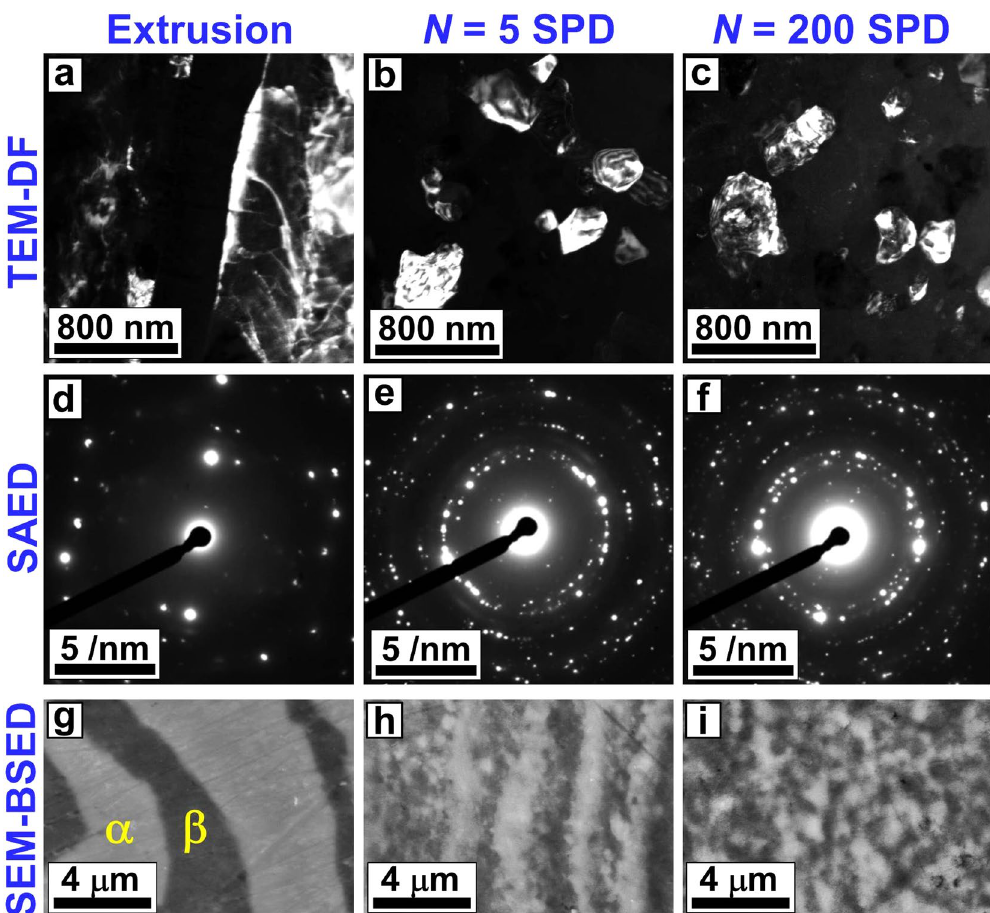
Figure 2. Ultrafine grains with average sizes of 460 nm and 240 nm are formed, and the fraction of α / β interphase boundaries increases to 0.55 μ m 2 / μ m 3 and 2.34 μ m 2 / μ m 3 in response to SPD processing for N = 5 and 200 cycles, respectively. Microstructure of Mg-Li alloy processed with extrusion and SPD for N = 5 and 200 cycles. ( a – c ) TEM-DF images showing the grain sizes. ( d – f ) SAED patterns showing the diffracted beams from the grains. ( a – c ) SEM-BSED images showing the distribution of α and β